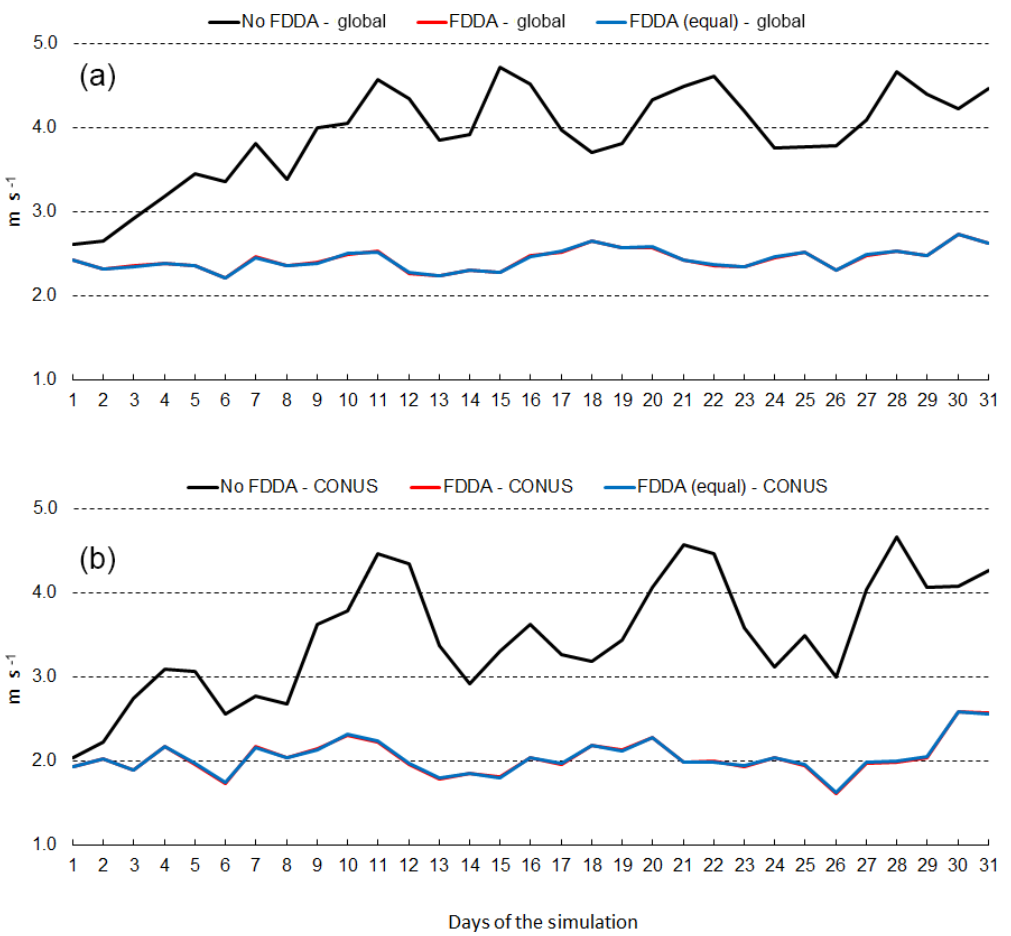
Figure 16. January 2013 time series plots of 10m wind speed RMSE for MPAS-A without FDDA (black line), MPAS-A with FDDA applied using weaker q v nudging (red line), and MPAS-A with FDDA applied at equal strength for all variables (blue line). Panel (a) shows results for the entire global domain, while (b) shows results for the CONUS